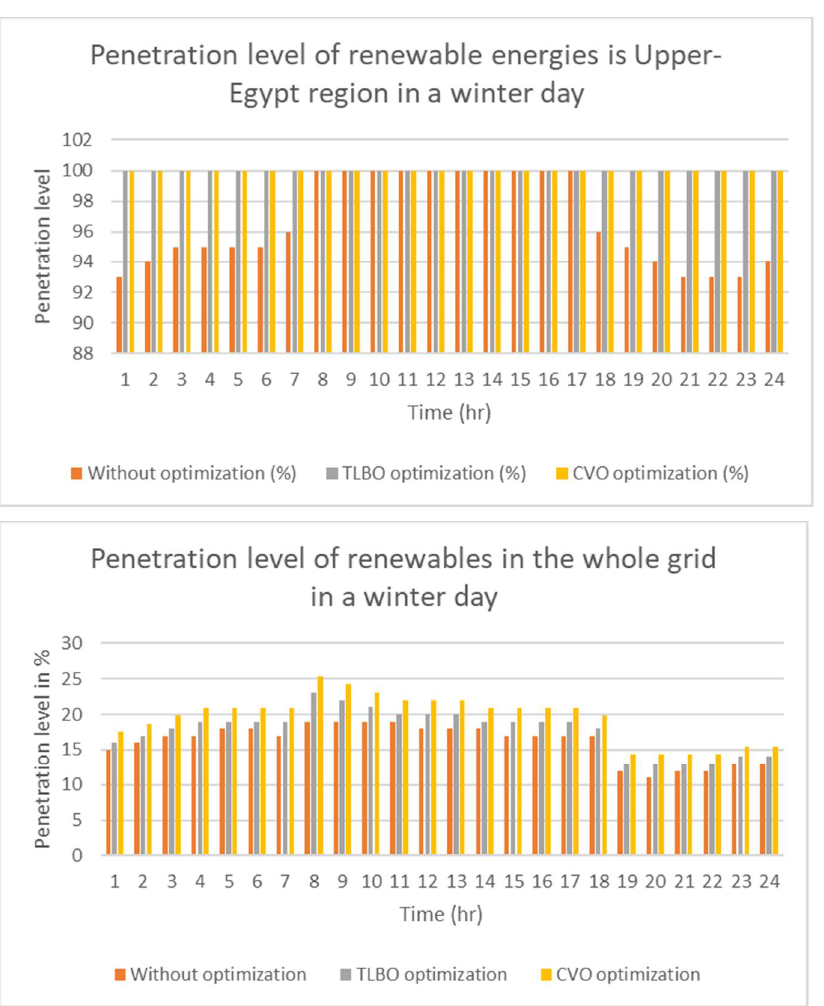
Figure 9. Penetration level of renewable energies in the Upper-Egypt region and the whole grid in a winter day.